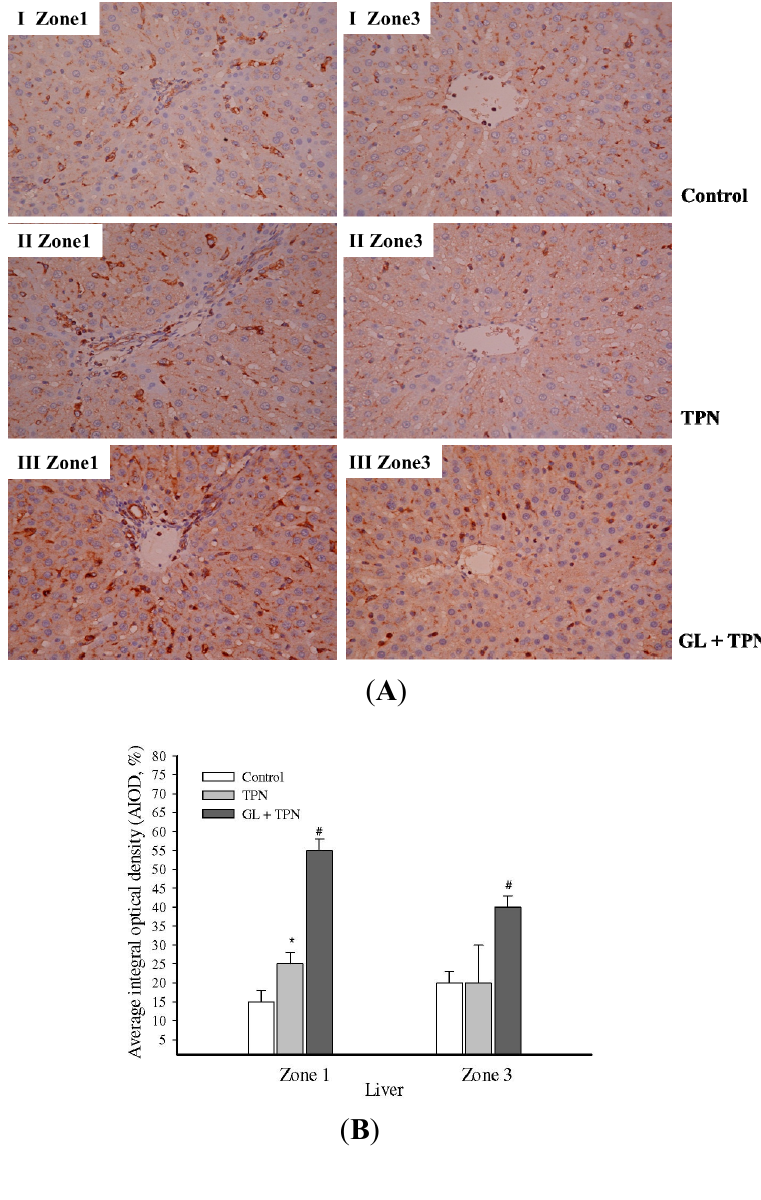
Figure 6. The effect of glycyrrhizin (GL) on liver cytokine-inducible SOCS3 protein levels. ( A ) Immunohistochemical staining for SOCS3 in rat livers was analyzed in different liver zonal areas: control rats (I); rats with TPN infusion (II); GL-pretreated rats (10 mg/kg) (III) staining of the portal and terminal hepatic venues zones; ( B ) The quantitation of immunohistochemical staining of SOCS3 levels by average integrated optical density (AIOD). The positive stained area was evaluated from three randomly selected observation fields of each liver section. The data represent the mean ± SD ( n = 6/group). * p < 0.05, compared with control group, # p < 0.05 between the pretreatment and TPN